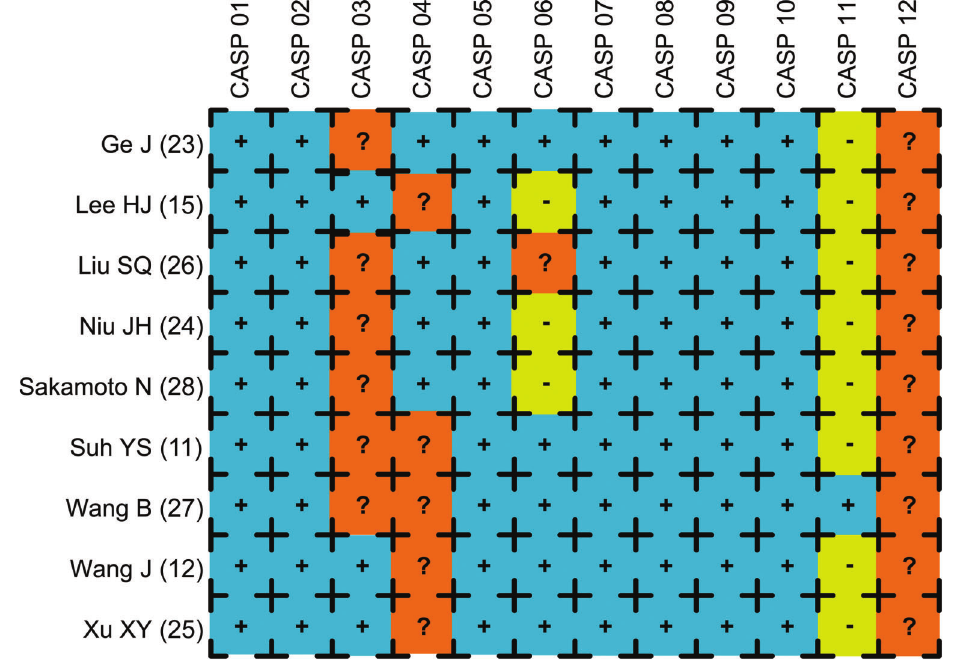
Figure 2. The Critical Appraisal Skills Programme (CASP) score for assessing the methodological quality of the nine enrolled cohort studies. CASP: o http://www.casp-uk.net/ 4 .